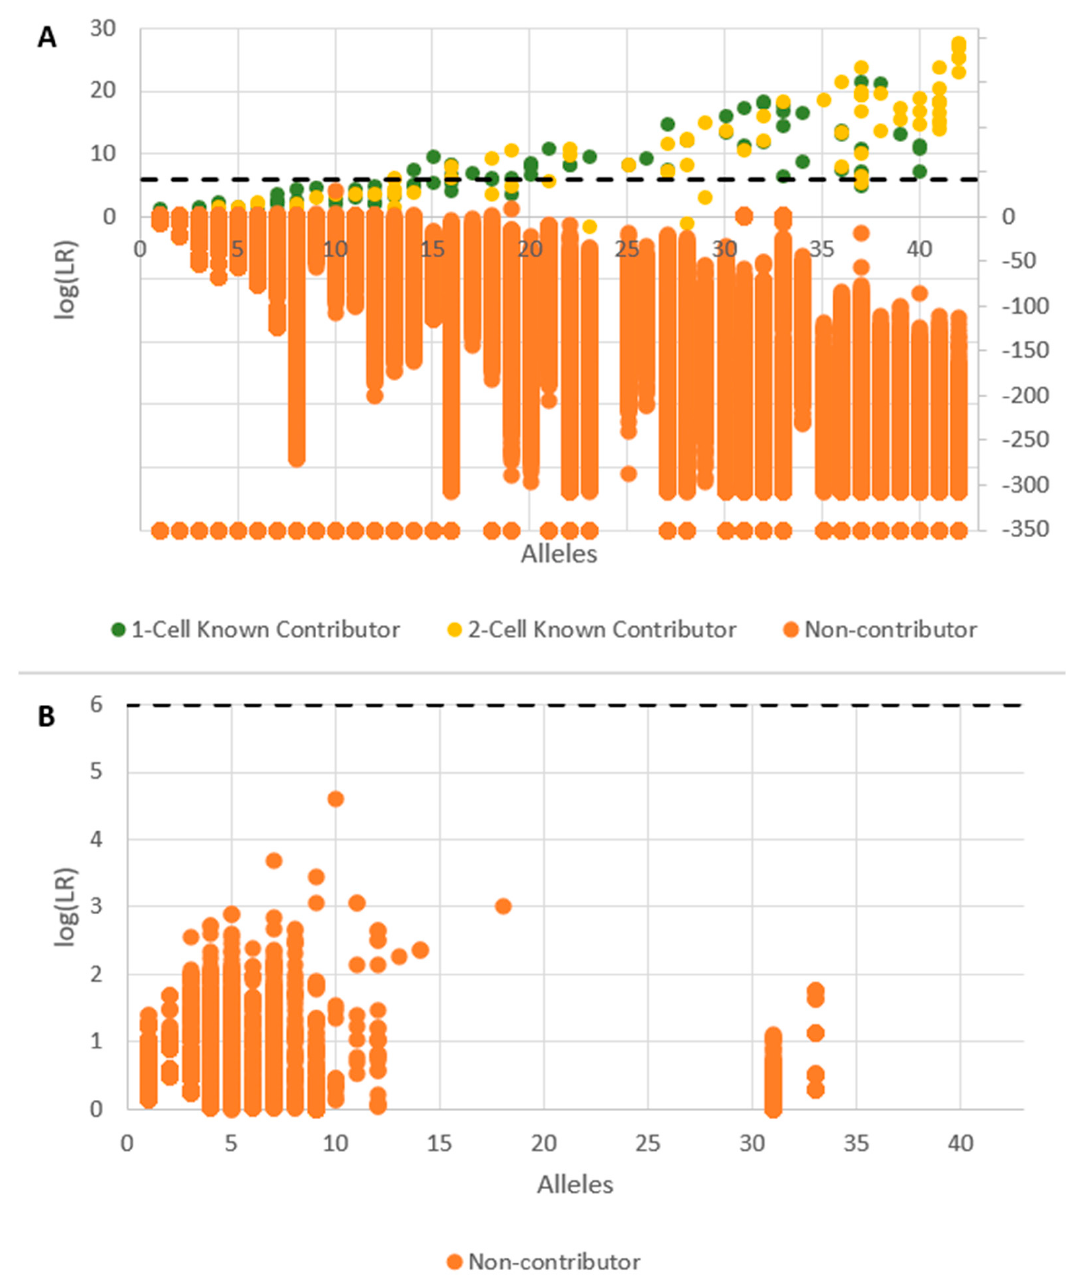
Figure 10. Sensitivity and specificity of DSCS (EFM) analysis with single source subsamples. LR = 0 plotted as − 350. Green circles (1-cell known contributor), yellow circles (2-cell known contributor), orange circles (non-contributor). Total results ( A ); False positives (i.e., log (LR) > 0) ( B ).